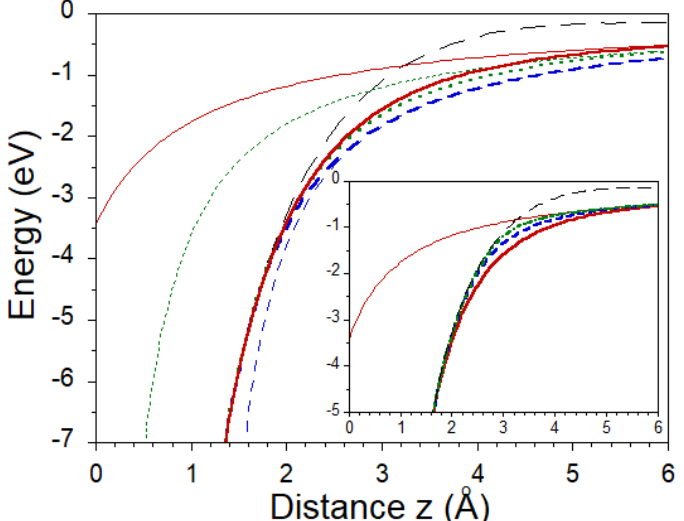
Figure 5. The LDA potential averaged in the x - y plane as a function of the z distance is shown by the thin dashed line. Hybrid “LDA+image − tail” potentials for z im = 0, 1.048, − 1.048 Å with the matching plane at z 0 =1.6 a.u. are presented as thick dotted, dashed, and solid lines, respec- tively. The corresponding bare image potentials are shown by thin dotted, dashed, and solid lines, respectively. Insert: Hybrid “LDA+image − tail” potentials constructed for z im = − 1.048 Å with the matching planes z 0 = 1.6, 2.1, and 2.6 Å are represented by thick solid, dashed, and dashed-dotted lines,